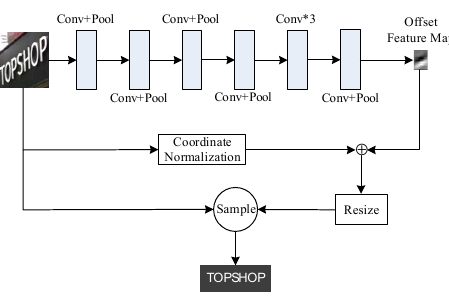
Figure 2. TPC structure diagram.